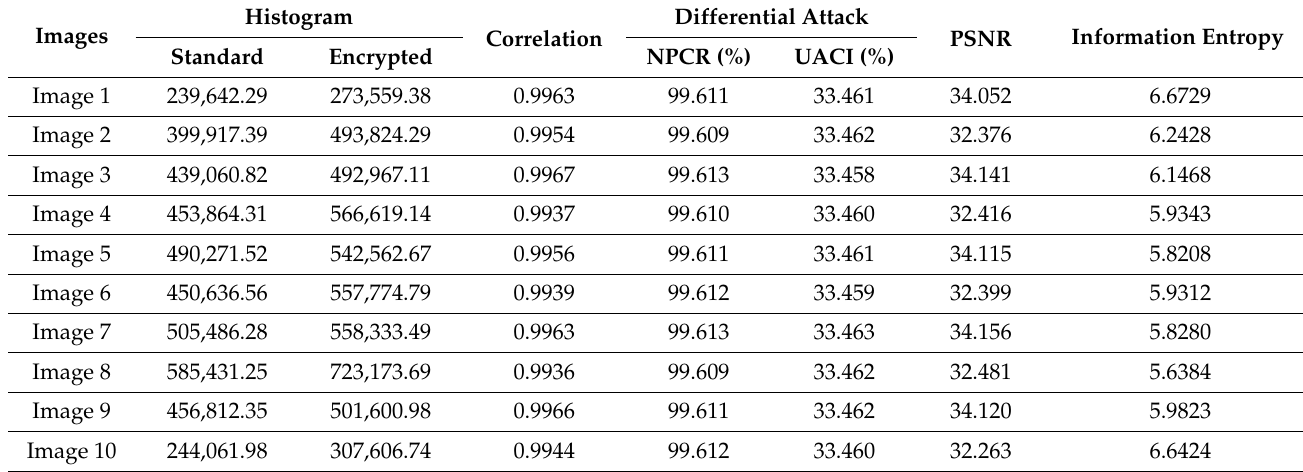
Table 3. Statistical metrics for CT Modality (Gaussian noise with 0.003